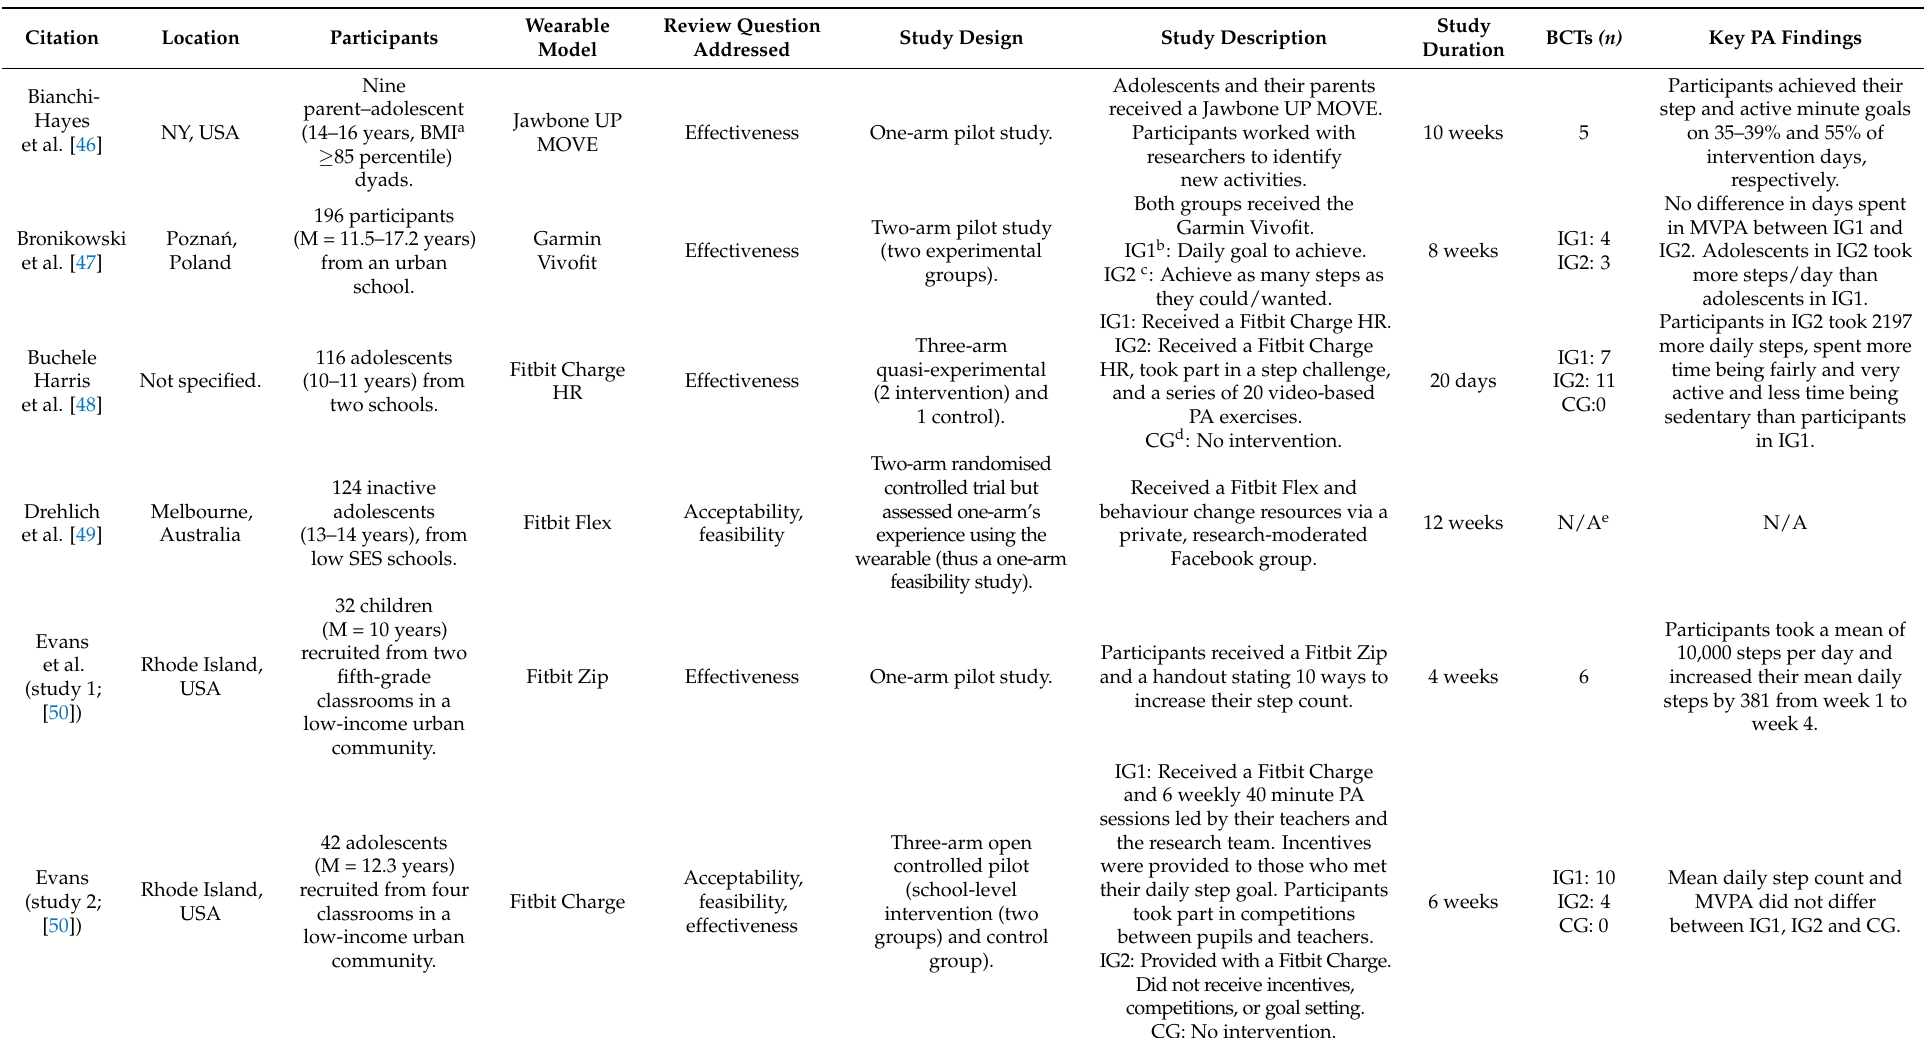
Table 2. Summary of included